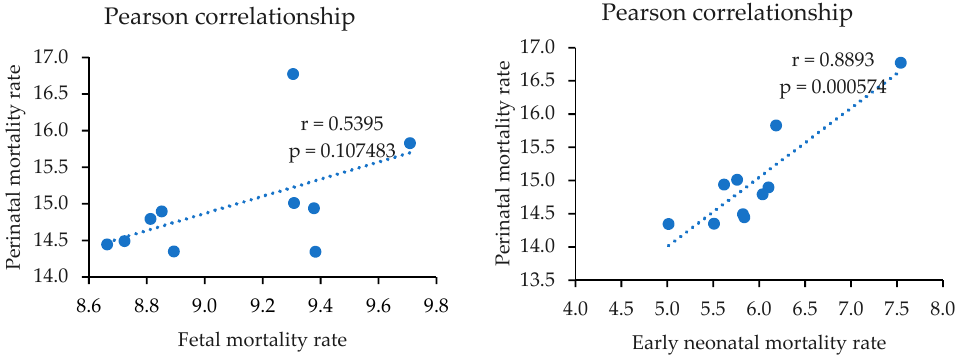
through the center of the cloud of points. Considering the significance level, alpha 0.05, standard error = 0.6853; there was a strong positive correlation for ENMR, PMR in the simple linear regression equation: ŷ = 1.04 (95% CI 0.60; 1.43) X + 8.80, r (9) = 0.8893, with a significance level of p = 0.000574 and a standard deviation = 0.3723. This means that high scores of variable X go with high scores of variable Y (and vice versa).